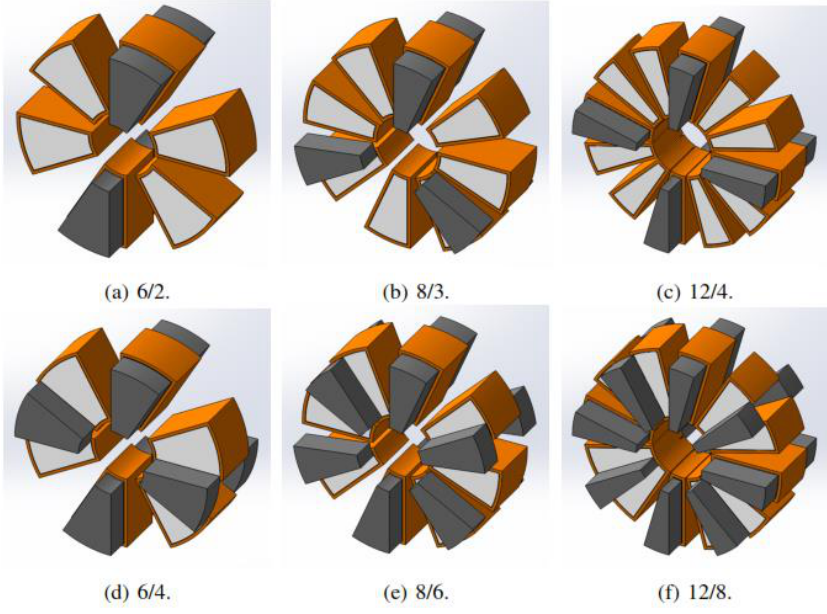
Figure 5. A set of examples of the AFSRM motor